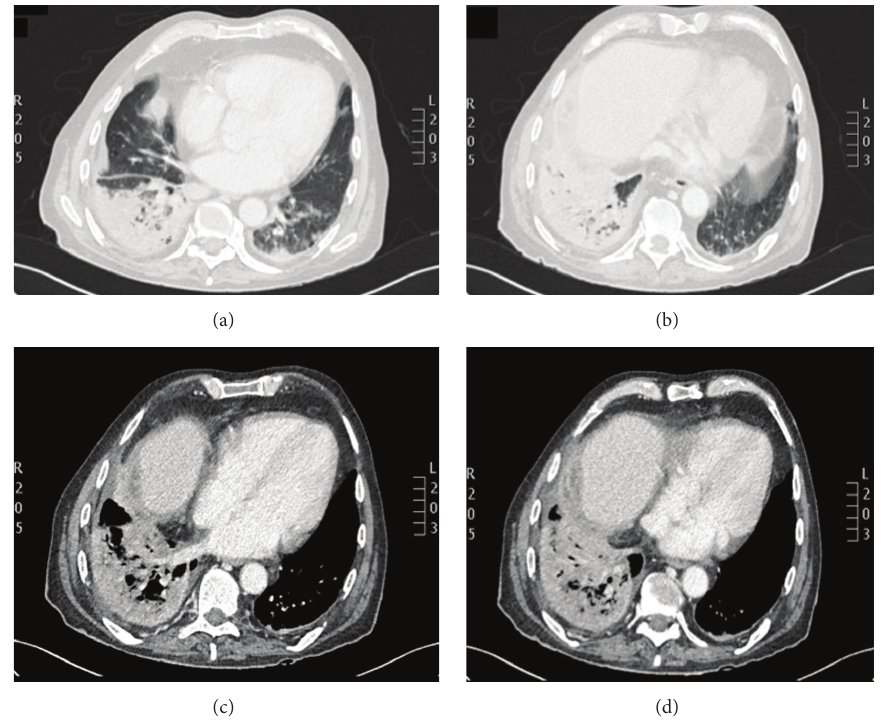
Figure 2: Computed tomography of the chest on admission. Right lower lobe alveolar consolidation with air bronchogram and in the left lower lobe and posterior segment of the left upper lobe similar lesions were identified in relation to a bilateral pneumonic process with associated loculated right pleural effusion and diffuse pleural thickening related to empyema.